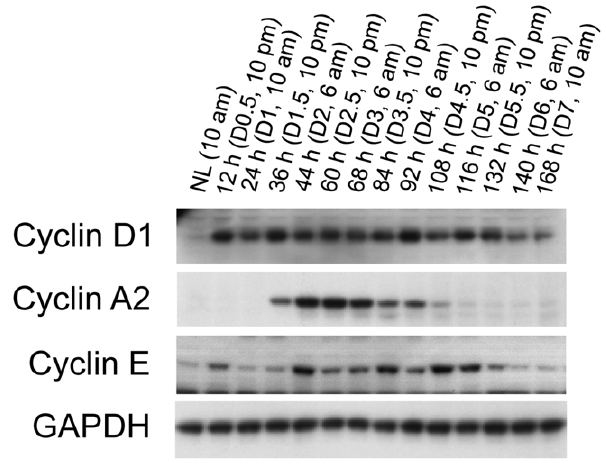
Figure 4. Hepatic expression of cell cycle components after partial hepatectomy (PH). Livers were collected at the indicated time points from normal mice and the mice subjected to PH. Liver lysates with equal amounts of protein from three mice per time point were pooled. Western blotting was performed with antibodies against the proteins indicated. Glyceraldehyde 3-phosphate dehydrogenase (GADPH) was used as a loading control. NL, normal liver.